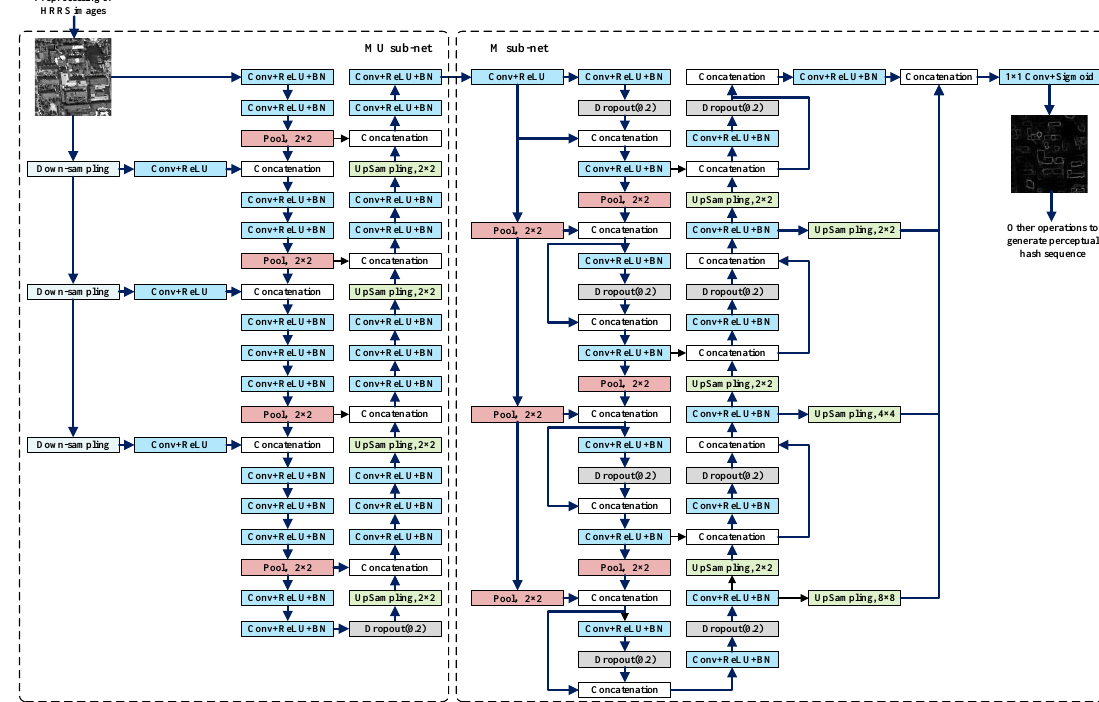
Figure 5. Detailed structure of our MUM-Net architecture. (Conv represents 3 × 3 convolution operation, ReLU (rectified linear unit) is the activation function, BN is the batch normalization layer, Concatenation is the feature fusion operation, Down-sampling is down sampling, UpSampling is up sampling, and Dropout is used to prevent overfitting.).